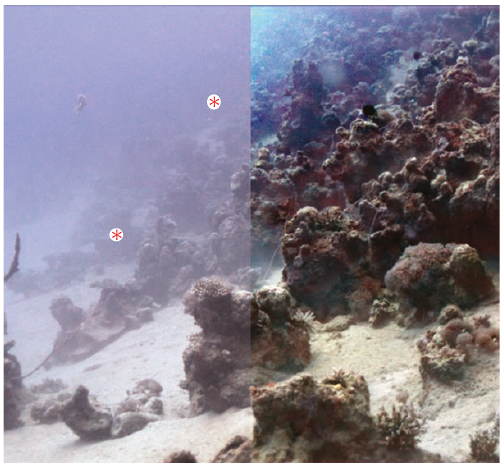
Figure 4: Underwater scene at the Red-Sea at 26 m below the water surface. Left, raw image; right, recovered image. Image courtesy of Schechner and Karpel